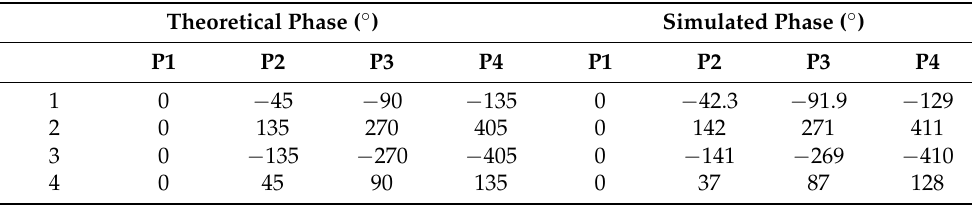
Table 4. Theoretical and simulation of output phase difference. Theoretical Phase ( ◦ ) Simulated Phase ( ◦